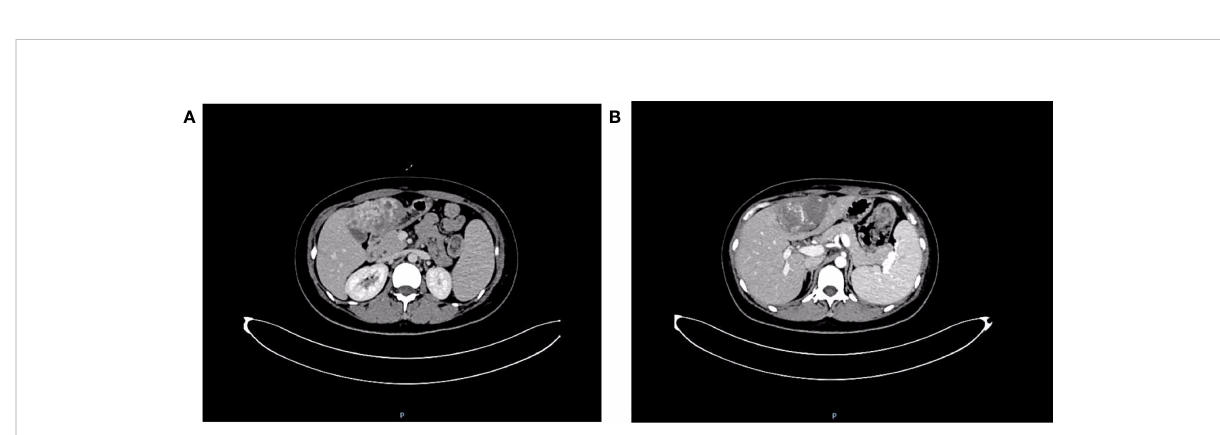
FIGURE 6 Cervical chest and abdominal computed tomography scan + enhancement show uneven enhancement of soft tissue mass in left lobe of liver. (A) Portal vein stage; (B) Delay stage.